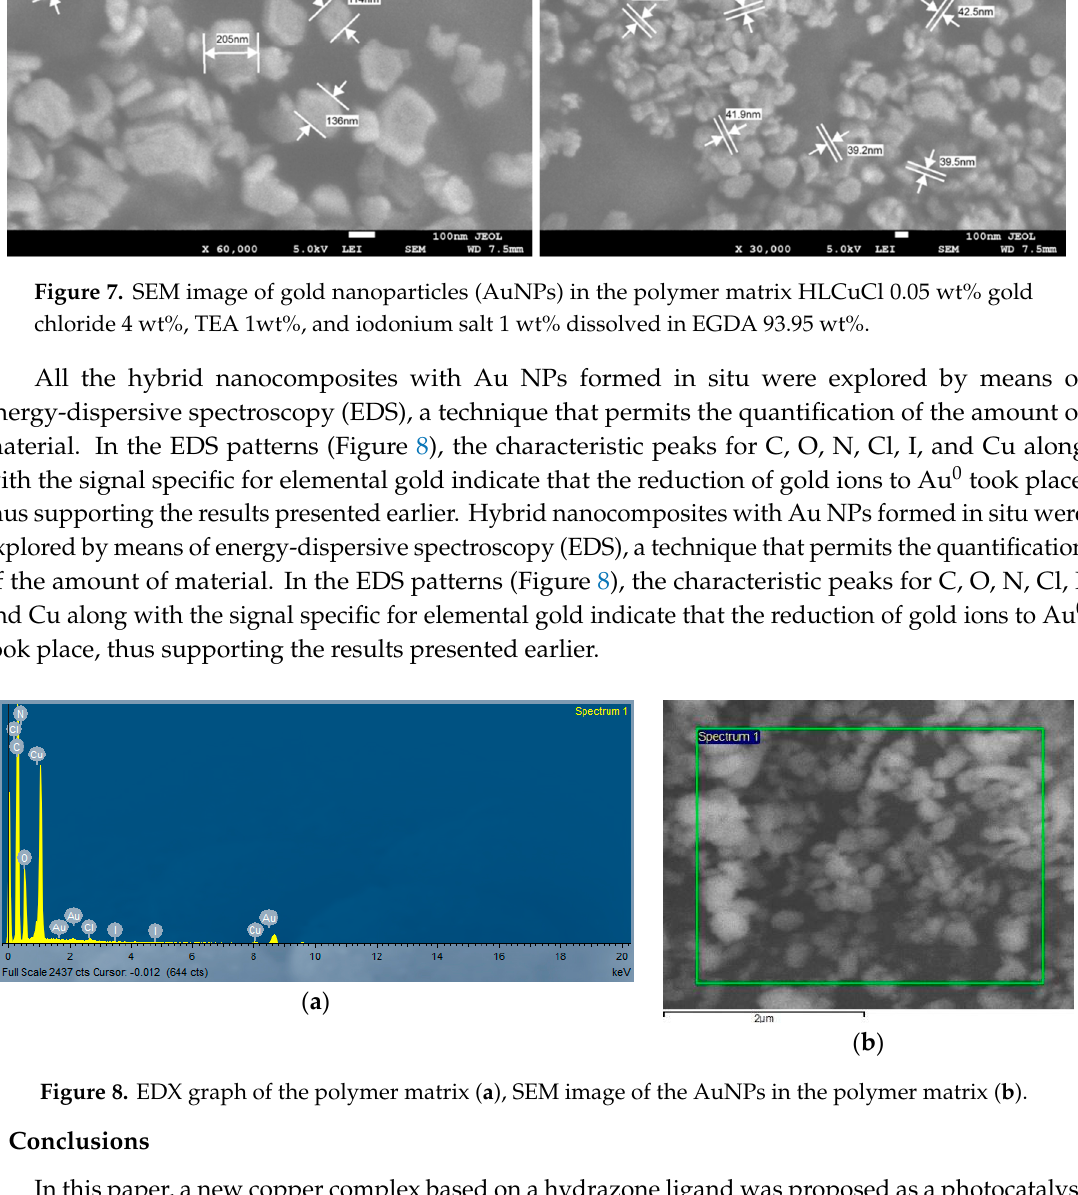
(HL). Figure S4: IR spectrum of the copper complex. Figure S5. DTA, TGA and DrTGA of the ligand (HL). Figure S6: Cyclic voltammogram of HLCuCl in acetonitrile. Figure S7: Photoluminescence of HLCuCl in DMF. Figure S8. Evolution of the absorption spectra of irradiated mixtures ( λ irr = 419 nm). Solution: HLCuCl 0.05 wt% and gold chloride 4wt% dissolved in 25 mL of DMF.